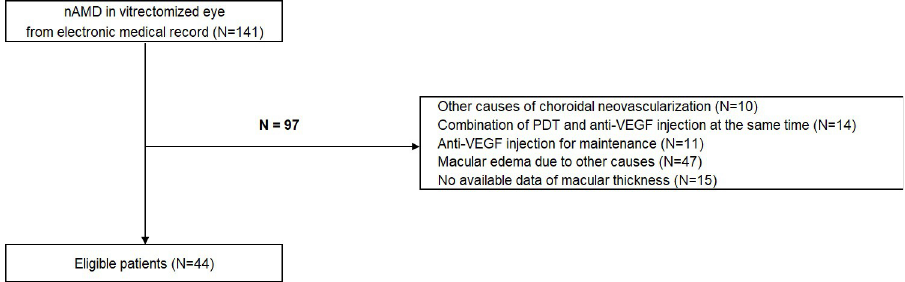
Fig 1. Flow chart of patient selection process. nAMD = neovascular age-related macular degeneration; VEGF = vascular endothelial growth factor; PDT = photodynamic therapy.